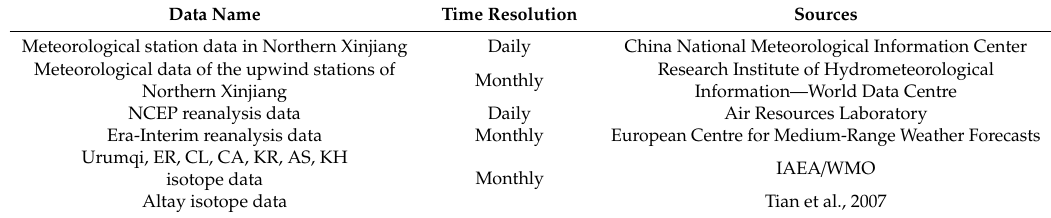
Table 2. Information on the meteorological station data, reanalysis data, and isotope